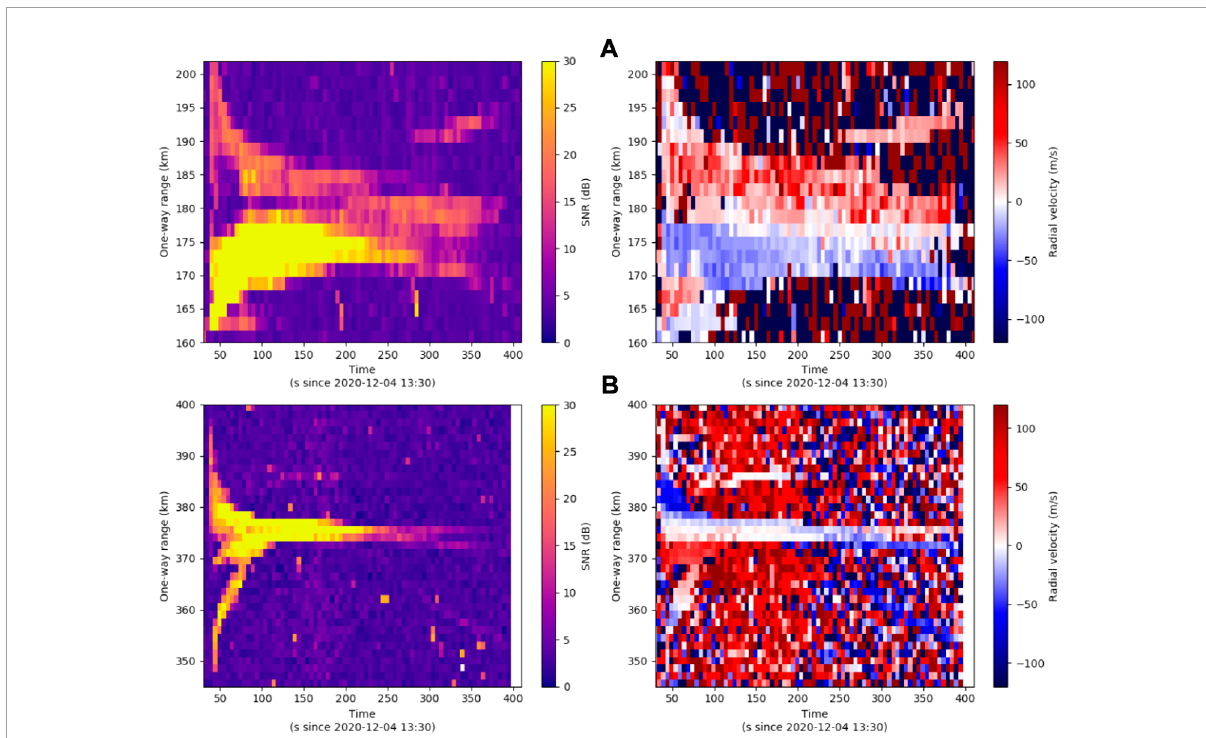
FIGURE 8 The long-lasting range-spread trail echo observed in (A) Sodankylä and (B) Andenes. Signal-to-noise ratio is shown on the left and Doppler shift is shown on the right. Towards the end of the trail, the trail can be seen splitting into three discernible parts as the trail is being transported due to the mesospheric neutral